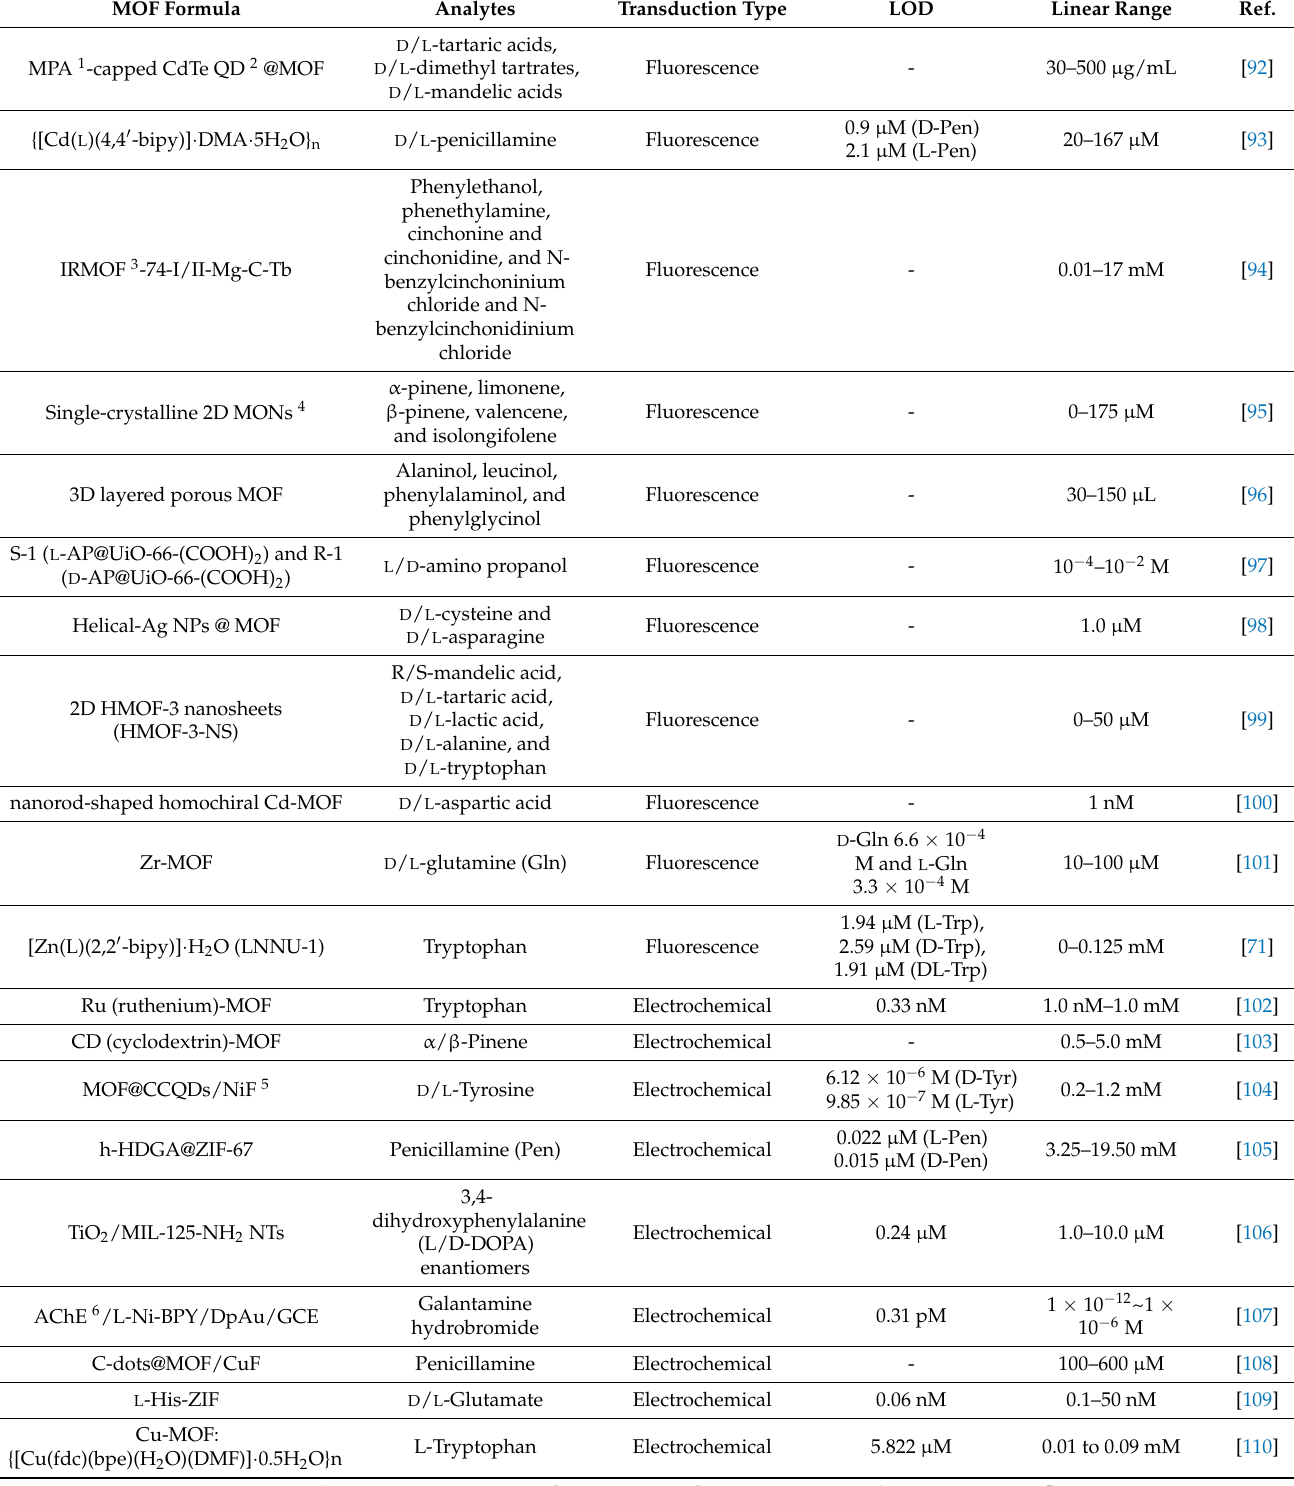
Table 1. Analytical performances of MOF-based enantioselective